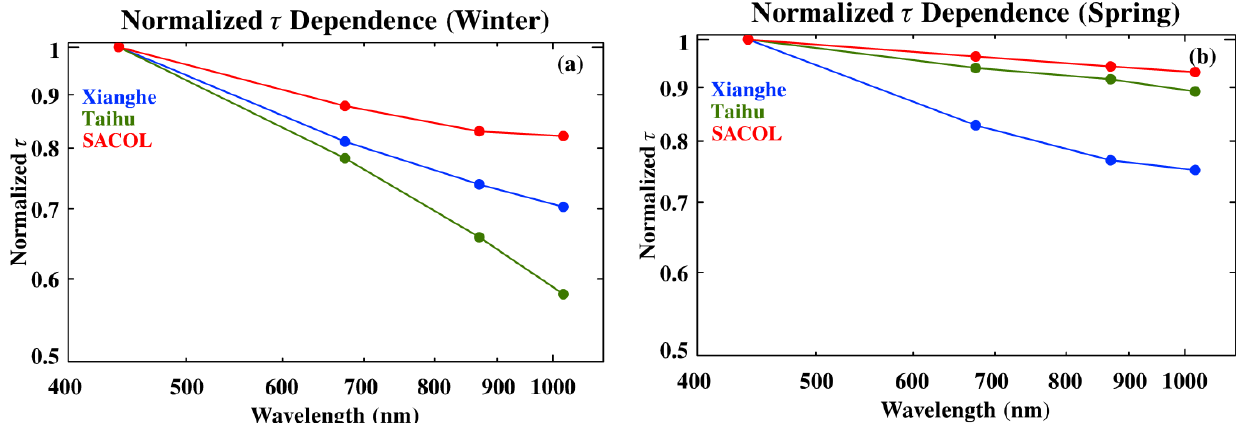
Figure 4. ( a ) Wavelength dependence of τ for the winter and ( b ) spring cases. The normalized τ values at each wavelength are ratios to the τ wavelength dependences across the three